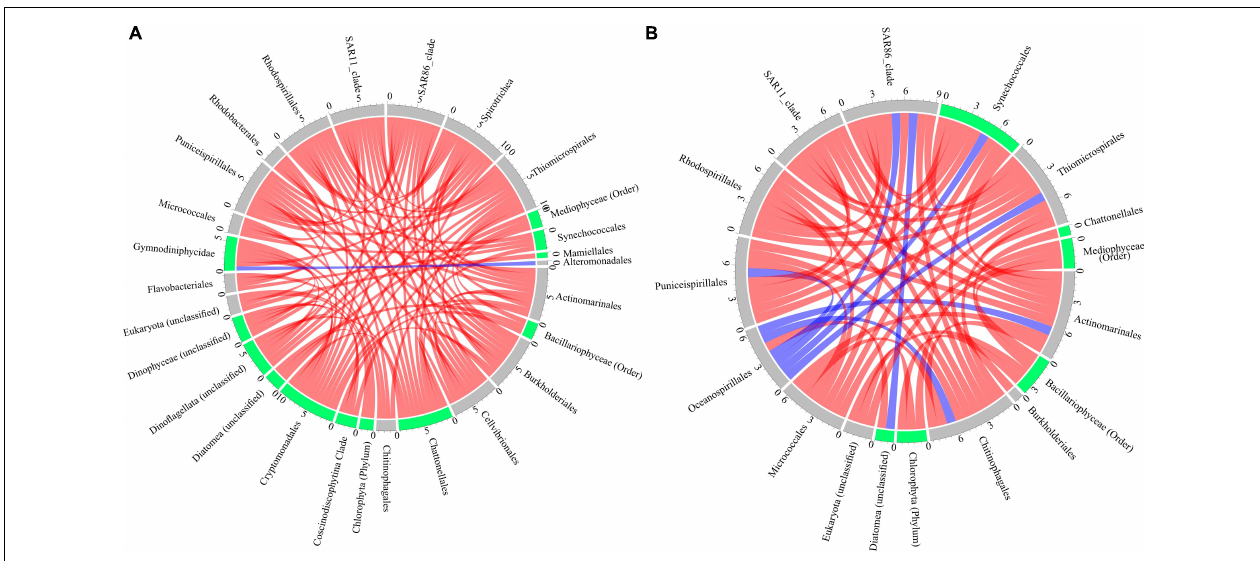
FIGURE 3 | Co-occurrence of prokaryotes and eukaryotes (cutoff of false discovery rate (FDR)-adjusted p -values < 0.0005 and Spearman’s rho values = ± 0.8) in the (A) control and (B) oil treatments, with red color indicating positive, blue color indicating negative co-occurrence, and blue- and gray-colored tracks labeling phototrophic and heterotrophic